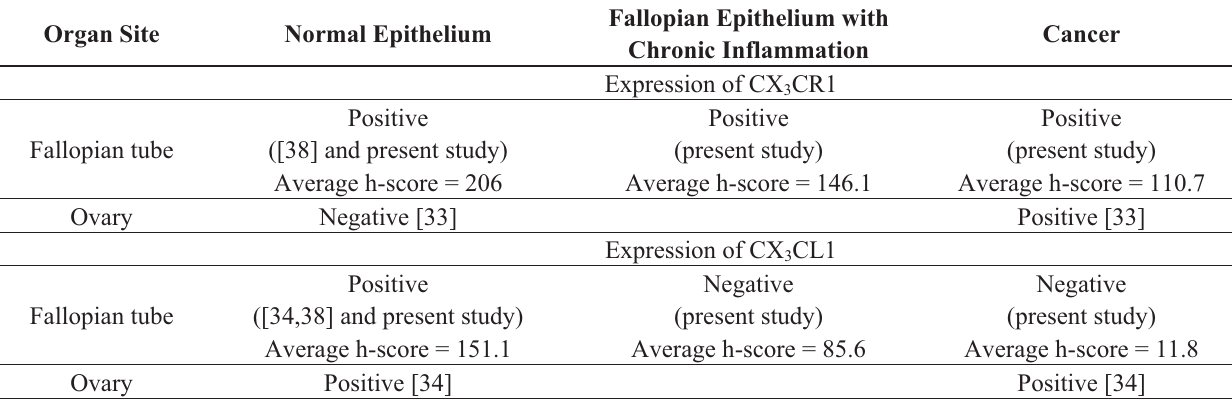
Table 1. Patterns of CX 3 CR1 and CX 3 CL1 expression in normal epithelium of ovary and fallopian tube, fallopian epithelium with chronic inflammation, ovarian carcinoma, and fallopian